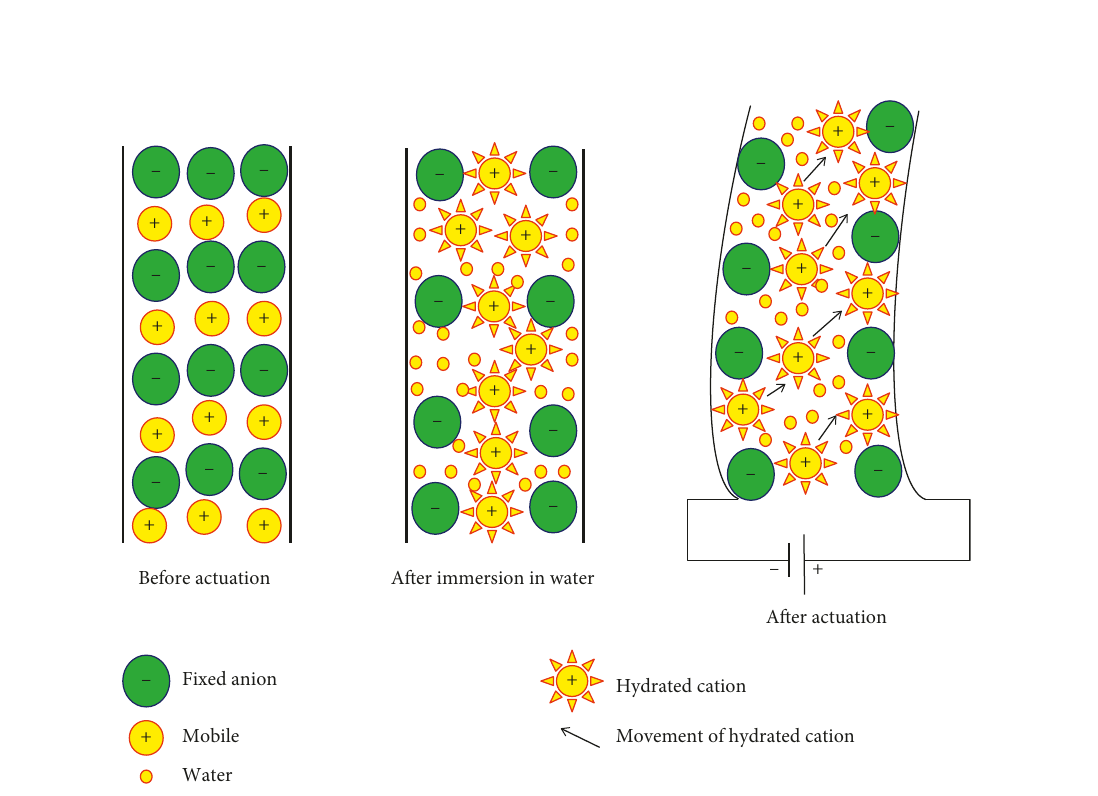
Figure 2: Bending mechanism of PANI/PVC-PEDOT: PSS-ZrP